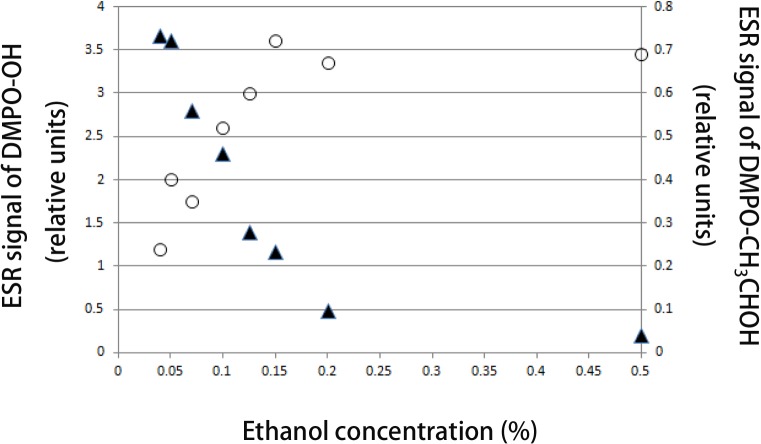
Effect of ethanol on ·OH formation.DMPO-OH adduct signal intensity decreasing with ethanol concentration with simultaneous increase in DMPO-CH3CHOH adduct signal intensity.